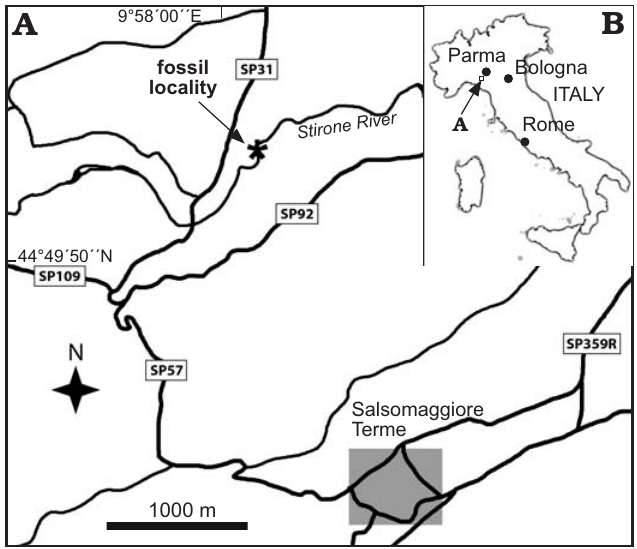
Fig. 1. Map showing location of Stirone River seep deposit on the map of Italy ( B ) and Salsomaggiore Terme region ( A ).